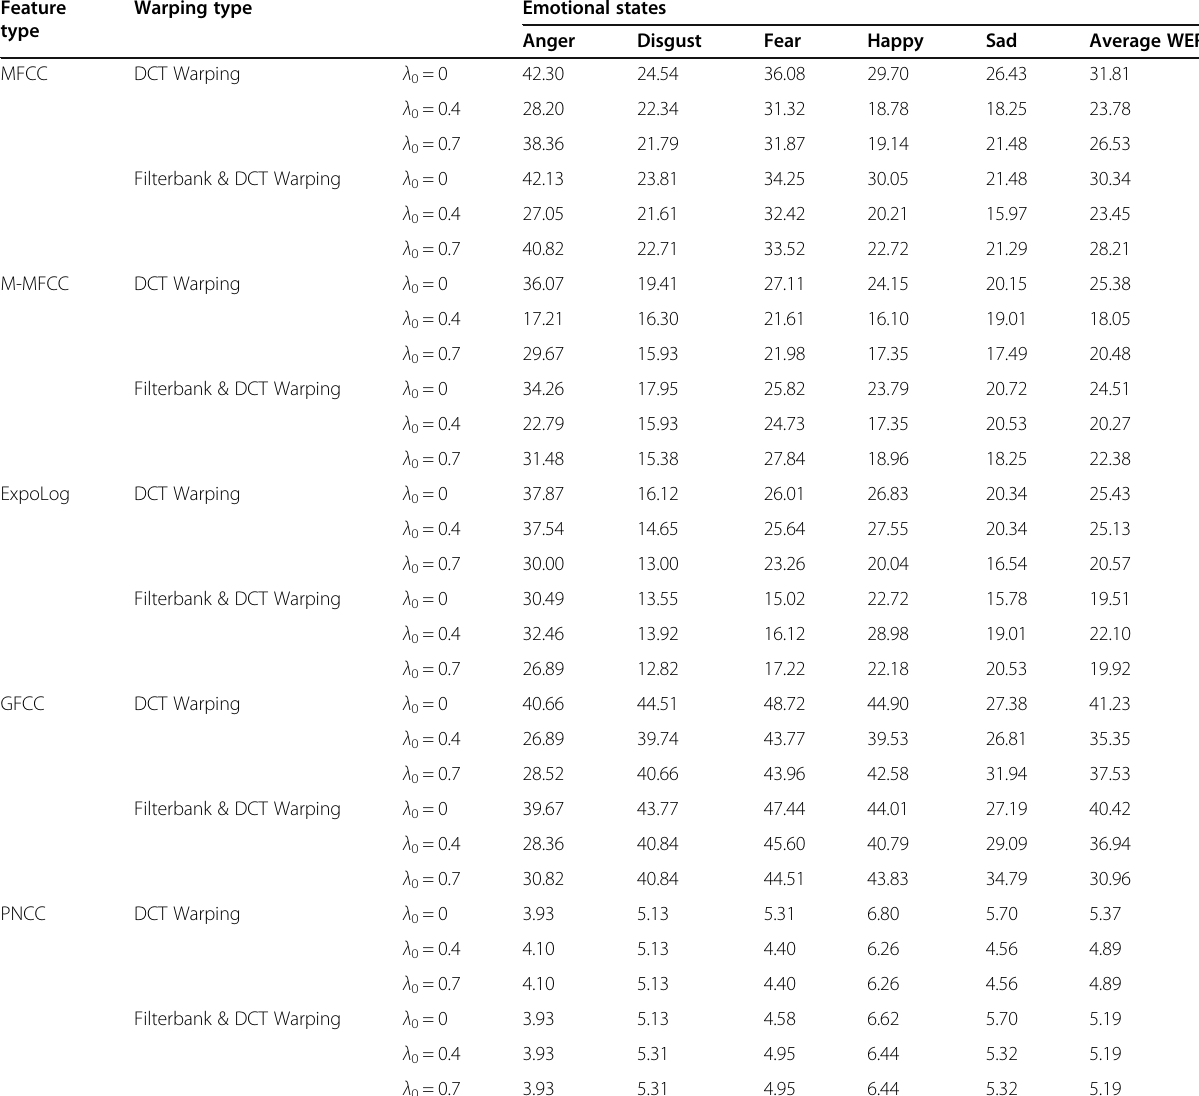
Table 2 The effect of modifying the normalized reference frequency, λ 0 , on the recognition performance of the proposed GMM- HMM EASR system (in terms of WER (%)) for Persian ESD. The values of WER are obtained by applying different warping methods to various acoustic features extracted from different emotional utterances Feature Warping type